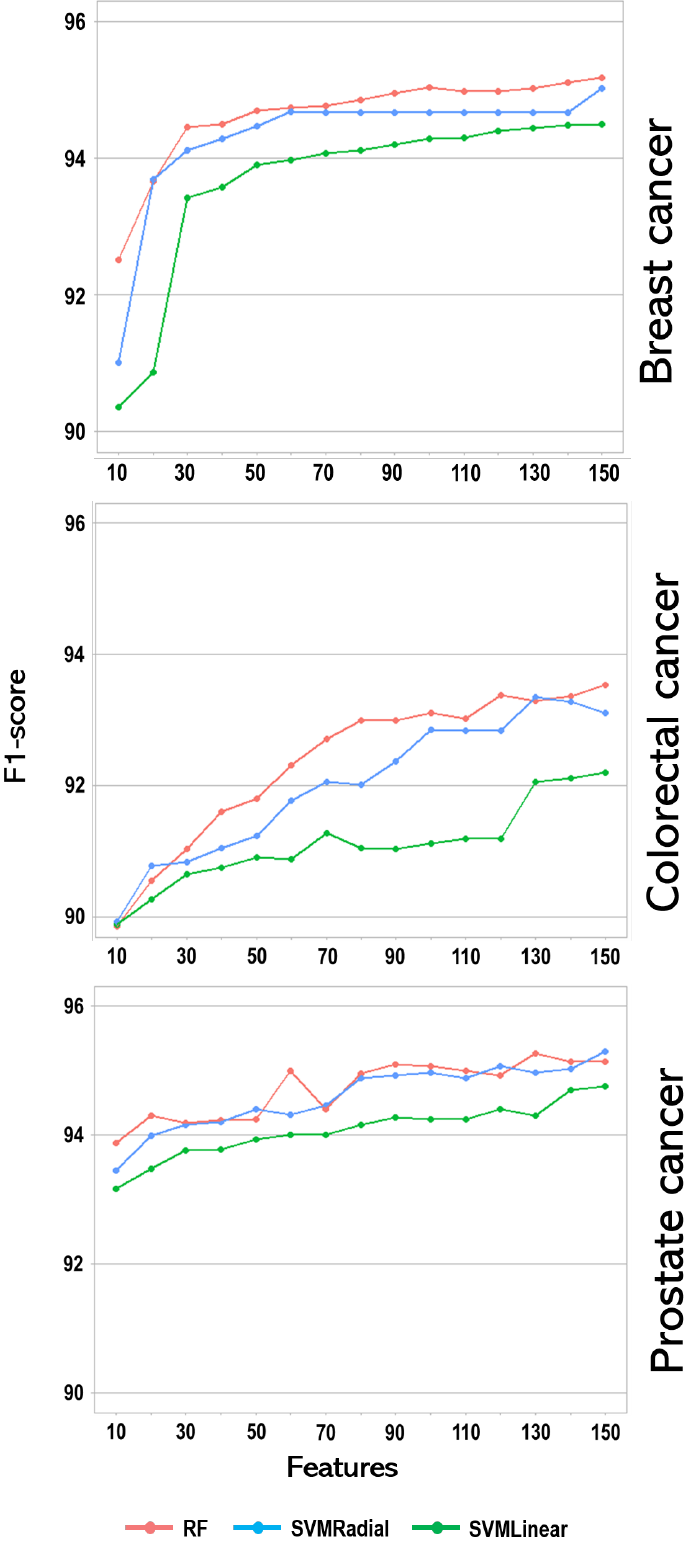
Figure 7. F1-scores of the RF, radial, and linear SVM models across the feature sizes for each cancer type. Different patterns in performance of each model are observed for each cancer